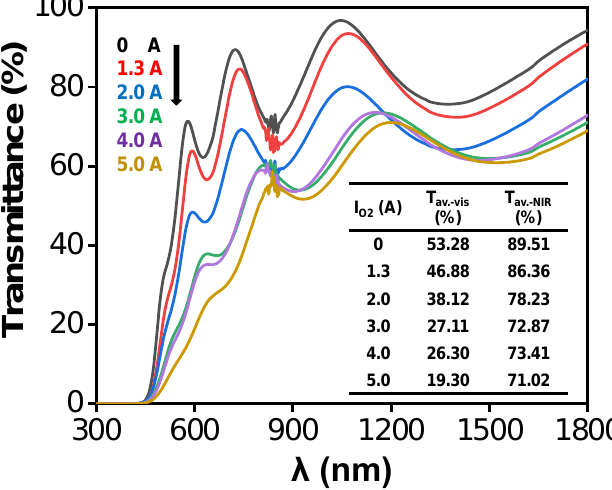
Figure 5. The transmittance of Cu 2 O films deposited with various oxygen ion beam current (the inset table compares the film’s average transmittance in visible region (400–800 nm) and in NIR region (800 – 2500 nm)).